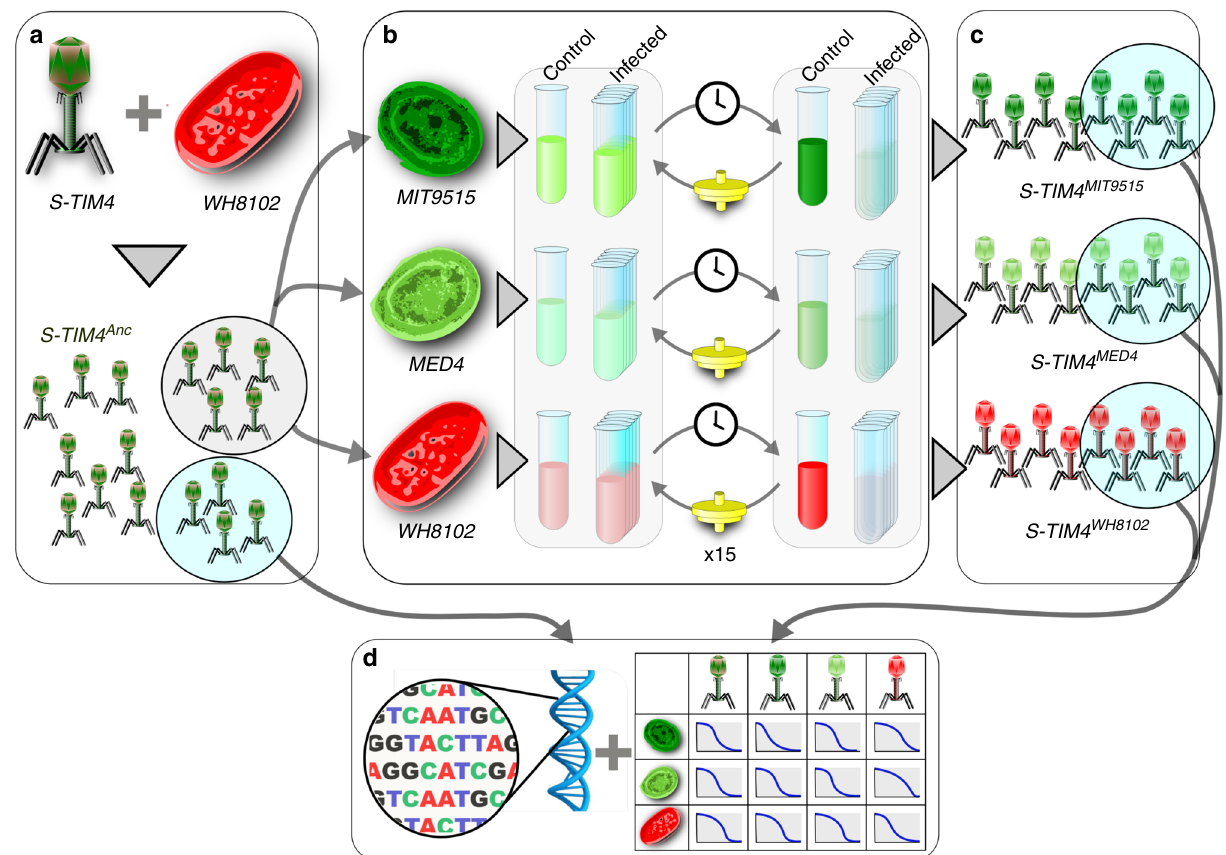
Fig. 1 Procedure for the experimental evolution of cyanophage S-TIM4 populations. a Generation of the ancestral population. A single viral plaque was isolated and replicated on the Synechococcus sp. strain WH8102 host, to yield an ancestral phage population (S-TIM4 Anc ). b Adaptation to speci fi c hosts. Aliquots of the ancestral population were evolved in three distinct cyanobacterial hosts: Prochlorococcus sp. strain MIT9515 (dark green), Prochlorococcus sp. strain MED4 (light green), and Synechococcus sp. strain WH8102 (red). Each infection interaction was repeated fi ve times (Infected) with one uninfected control culture (Control) for each cyanobacterial strain. Following lysis of the infected cultures, phage lysates (<0.22 µ m) were transferred to infect the same naïve cyanobacterial hosts. This process was repeated for an additional 14 transfers. c Evolved populations. The adaptation phase resulted in populations adapted to MIT9515 (S-TIM4 MIT9515 ), MED4 (S-TIM4 MED4 ), and to WH8102 (S-TIM4 WH8102 ). d Characterization of ancestral and evolved populations. Whole genome DNA sequencing of the entire population for the ancestral and each of the evolved populations was conducted (left). In parallel the infectivity of each population on each of the hosts was tested